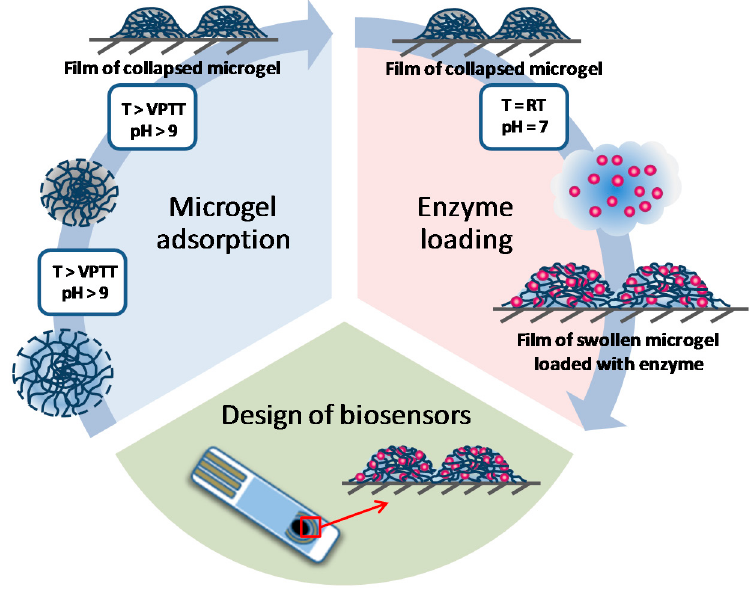
Scheme 1. Bottom-up construction of microgel-based biosensor